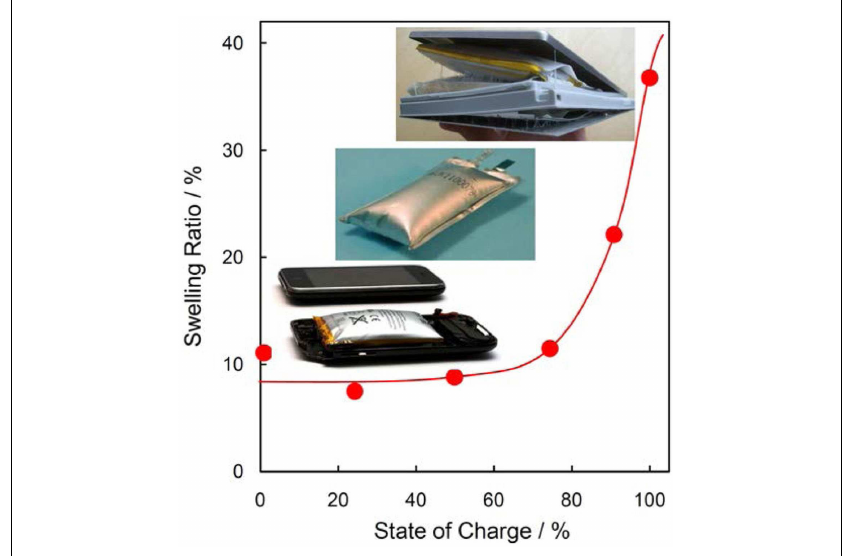
FIGURE 1 |A trend of swelling ratio with SOC for graphite/LiCoO 2 prismatic cells stored at 90°C for 4h . Drawn from the data of Lee et al. (2003).